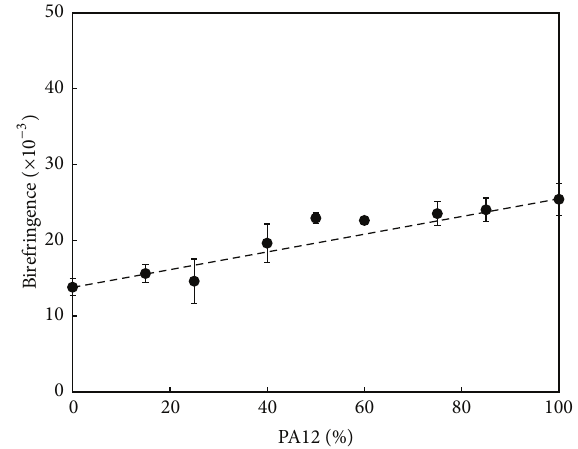
Figure 5: Birefringence of the gPP/PA12 blends, as a function of the PA12